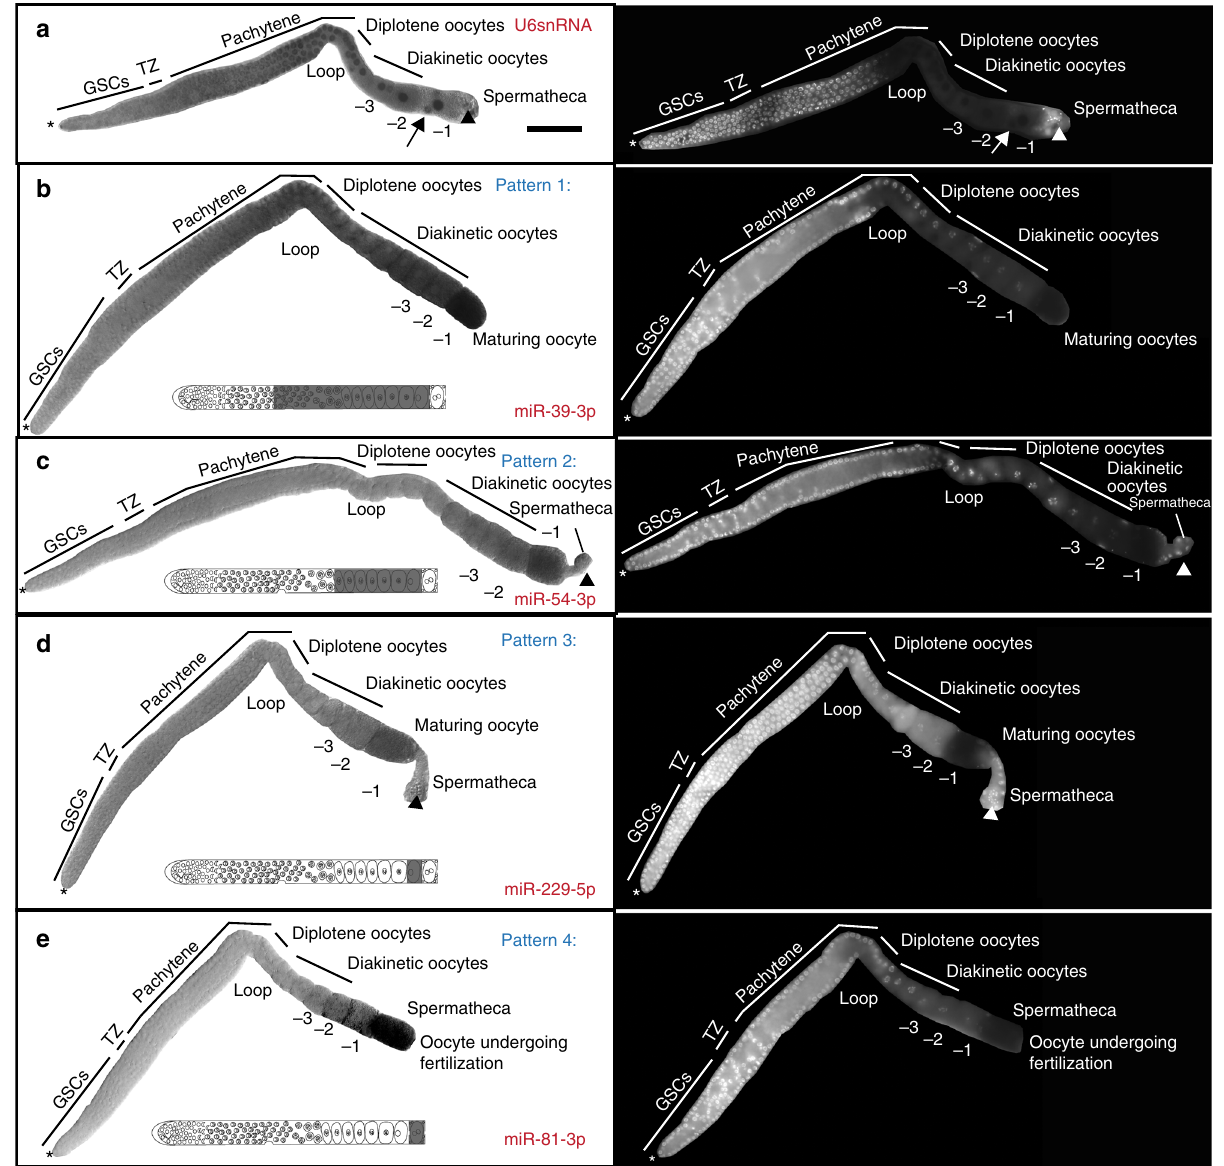
Fig. 2 Oogenic miRNAs localize in four spatial patterns in the germline. Dissected germlines, oriented left to right, with oocytes on the right. Asterisk marks the distal tip cell. Bright- fi eld (left) images of germlines. Dark staining is indicative of positive probe expression. DNA (white, stained with DAPI, right panel) staining labels distinct germ cell nuclear stages. The schematic in each panel depicts miRNA localization, gray labeling highlights positive probe expression. a U6 small nucleolar RNA, expresses in all germ cell nuclei (arrowhead marks sperm) and the somatic gonad nuclei (arrow marks somatic sheath cells). b Pattern 1 miRNA, miR-39-3p, localizes to the cytoplasm of late pachytene cells, diplotene oocytes, diakinetic oocytes, and maturing oocytes, but not in sperm cells or somatic sheath cells. c Pattern 2 miRNA, miR-54-3p, localizes to cytoplasm of diplotene oocytes, diakinetic oocytes and maturing oocytes. d Pattern 3 miRNA, miR-229-5p localizes to cytoplasm of the maturing oocyte. Arrowhead marks sperm, which are negative for the miRNA. e Pattern 4 miRNA, miR-81-3p localizes to the cytoplasm of an oocyte undergoing fertilization in the spermatheca. None of the miRNAs positively localized to the somatic gonadal cells or sperm cells. Each experiment was performed three times, 75 – 100 gonads were dissected for each replicate and ~20 – 30 germlines were imaged for each replicate. Scale bar: 20 μ